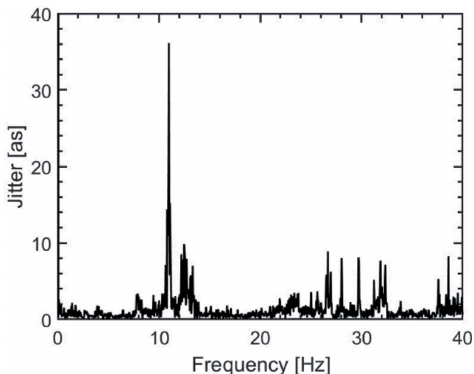
Figure 10 Fast Fourier transform of the interference measurements with visible light. The SDU with dampers shows a prominent resonance at 11 Hz arising from the incoupling of ground vibrations from the hall.